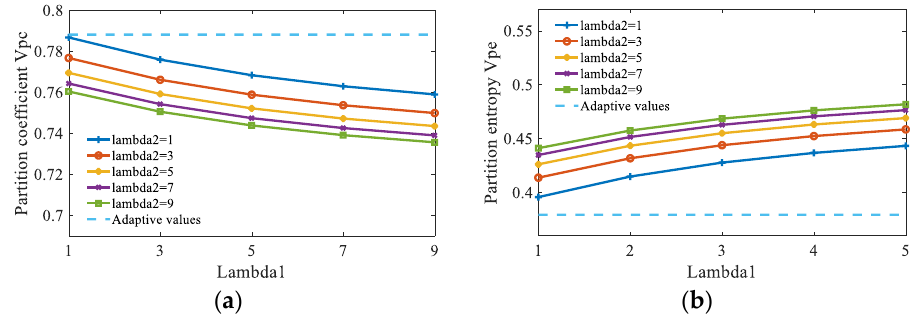
Figure 9. The partition coe ffi cient v pc , and partition entropy v pe of FCM_NNS with di ff erent scale